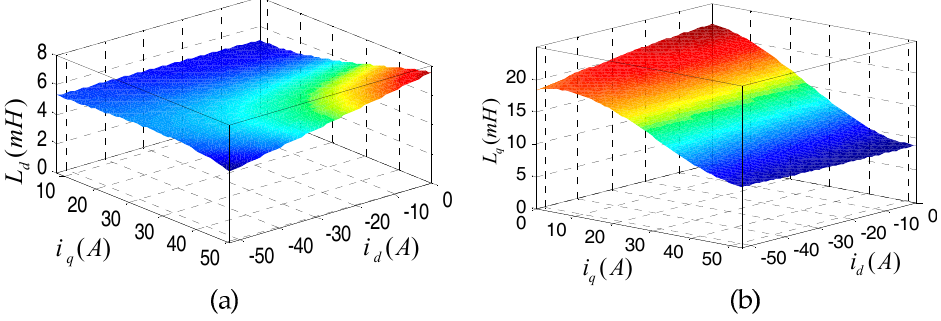
Figure 3. Nonlinear stator inductance as a function of the dq -axis current. ( a ) d -axis inductance; ( b ) q -axis inductance.